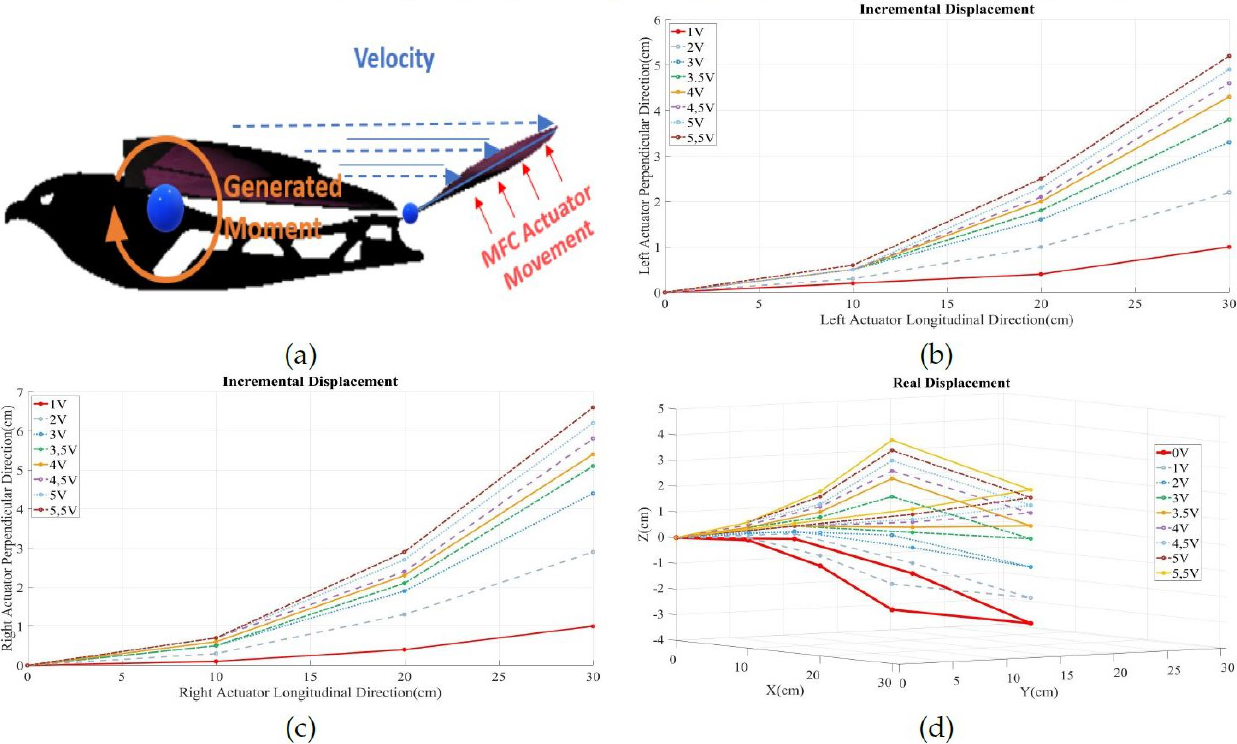
Figure 8. Tail Raise Feasibility Experiments. ( a ) Shows the potential behavior of the tail. ( b , c ) show the displacement of both the left and right actuators. ( d ) Shows a three-dimensional (3D) representation.